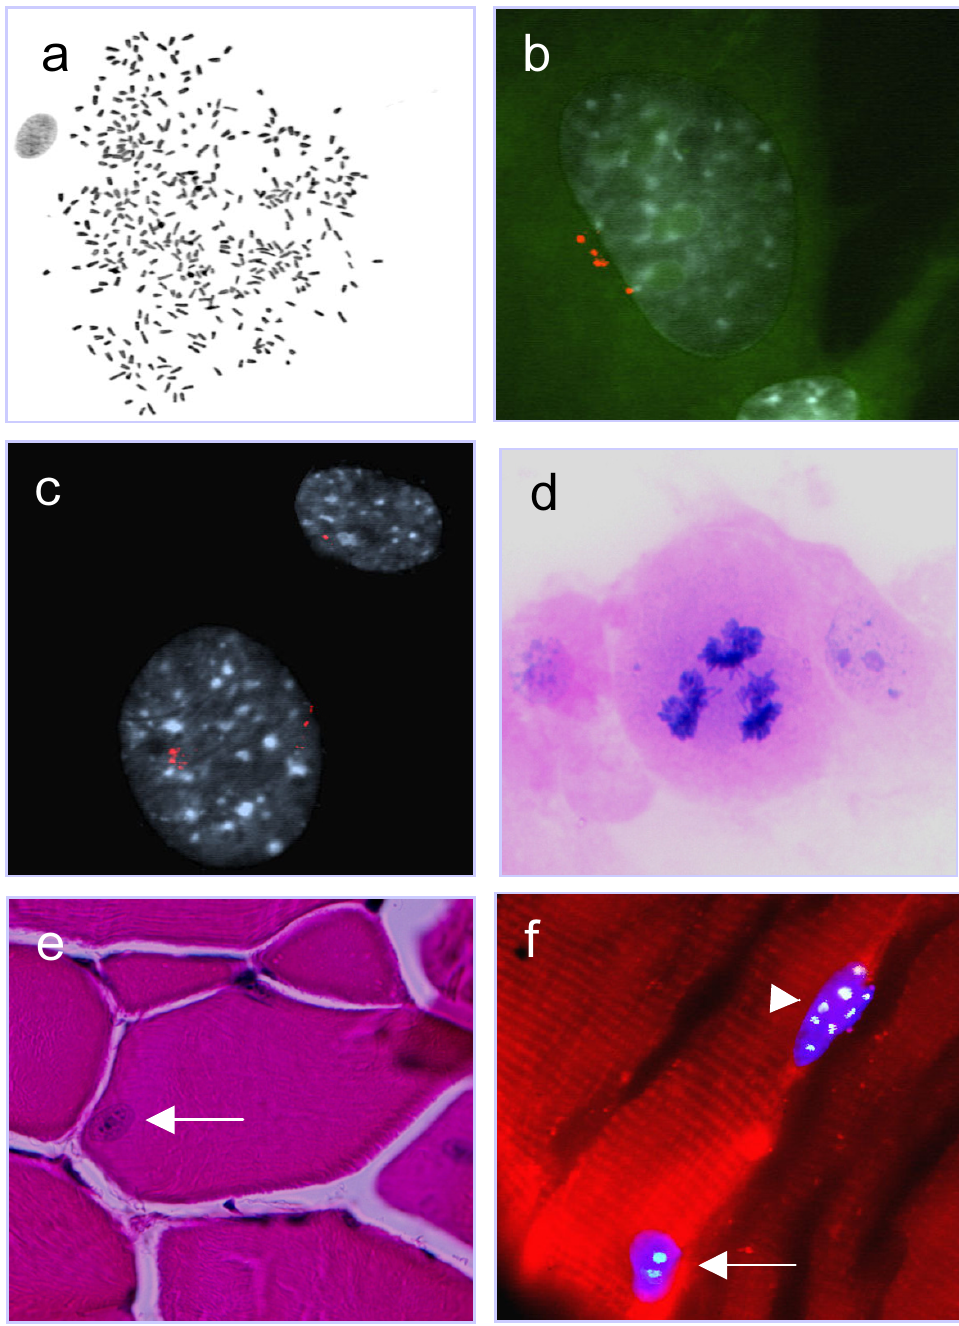
Figure 1 Cytogenetic and immunofluorescent analysis. G-banded polyploid metaphase cell from wt31 abdominal muscle (a). Mul- tiple centrosomes (red) in cells from the peritoneal fat of R6/2 78 (b; green autofluorescence indicates cytoplasm) and from the abdominal muscle of wt77 (c; autofluorescence removed for clarity). Tripolar anaphase cell visualized by haematoxylin-eosin staining in a cell (passage 1) from the abdominal muscle of wt30 (d). Large nucleus (arrow) in a skeletal muscle fibre from wt77 (e). One nucleus with two chromocenters (arrow; green) and one with eight chromocenters (arrowhead) in a skeletal muscle fibre from wt76